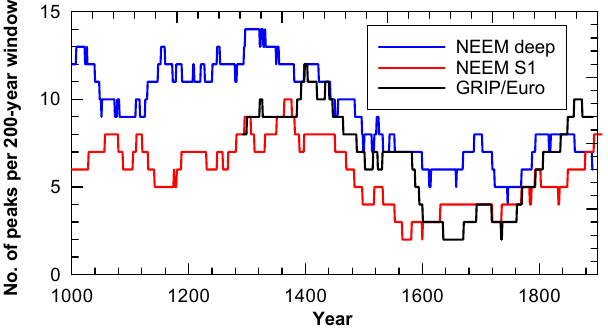
Figure 14. Fire peak frequency in a running 200-year window for the Eurocore at Summit (black), the NEEM deep core (blue), and the NEEM-2011-S1 core (red). Peaks detected in adjacent years were only counted as